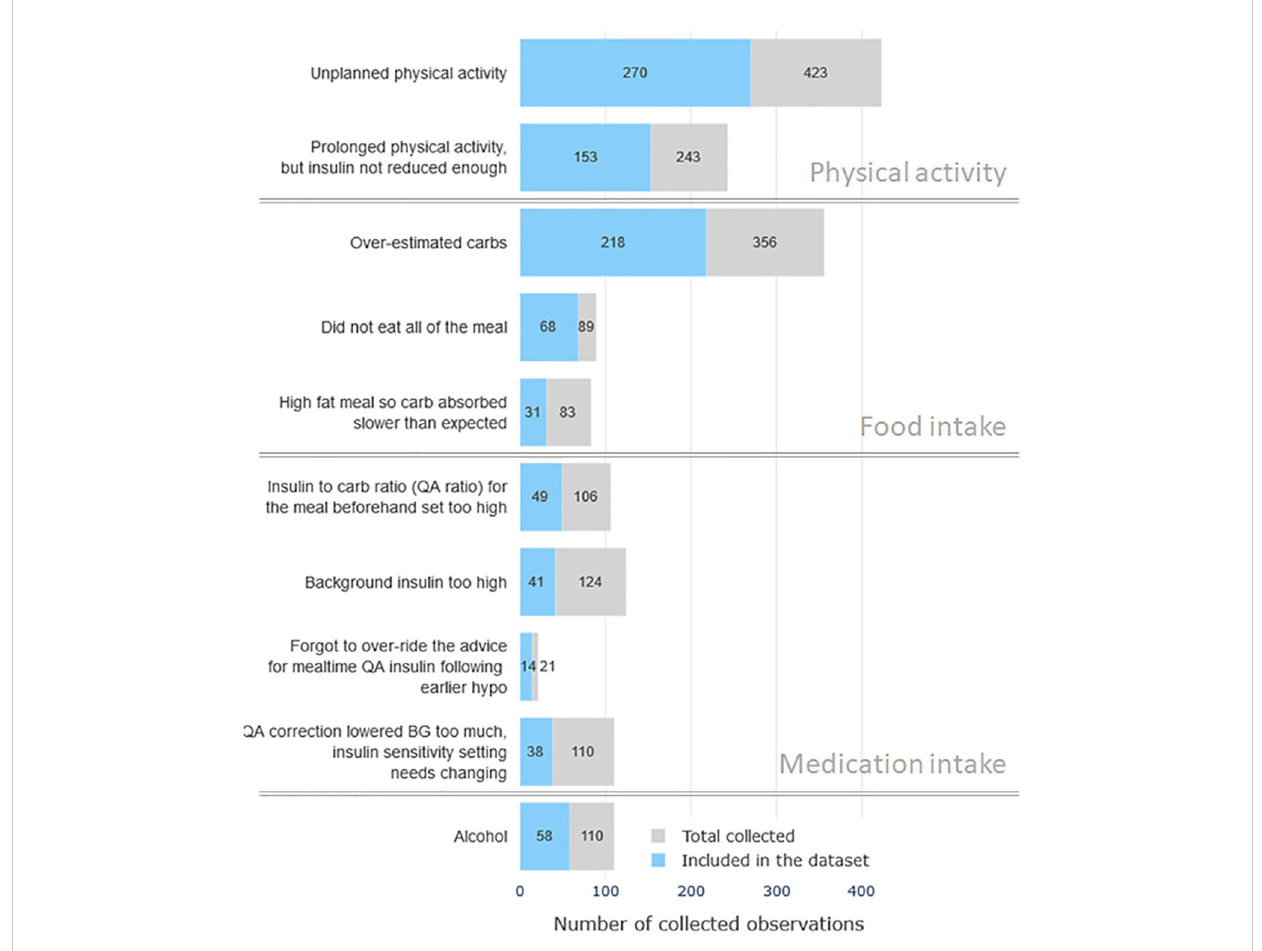
FIGURE 2 The distribution of the observed hypoglycemia cases by reasons. Gray color bars mark the total number of collected cases and the blue color bars denote the number of high-con fi dence cases included in the analysis